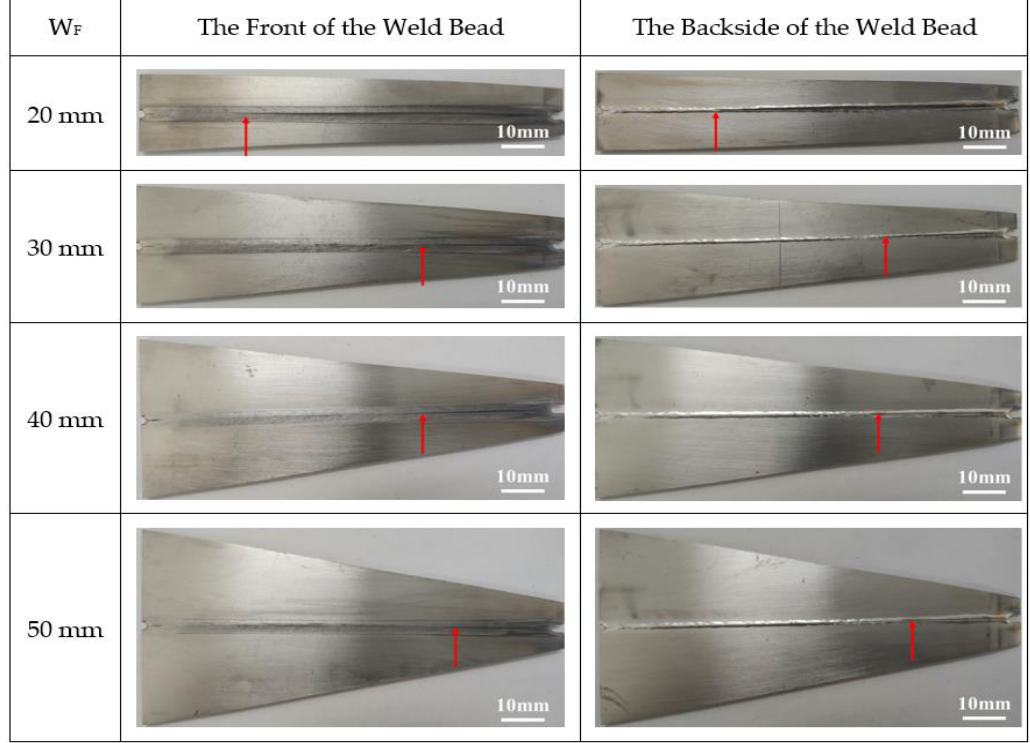
Figure 6. Macroscopic appearance of the solidification cracking of SUS310 stainless steel under W S of 12 mm and the different values for the final edge of the welding process (W F ) during laser welding at a welding speed of 1.0 m/min.